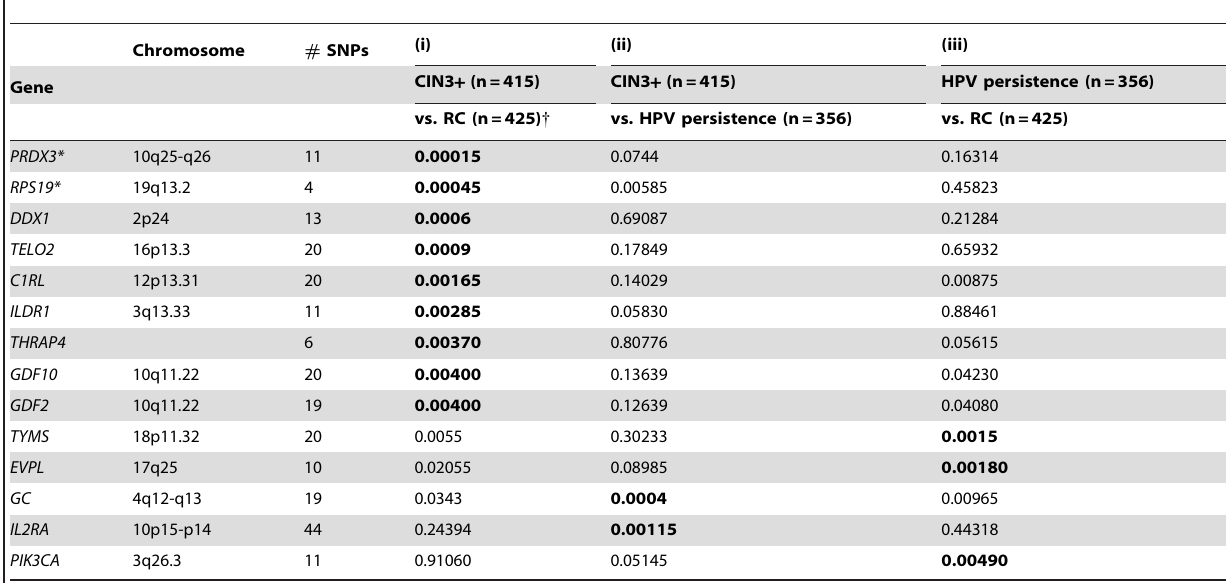
Table 1. Significance levels (p values) for gene regions with p # 0.005, for either an association with (i) cervical precancer/cancer, (ii) progression to cervical precancer/cancer, (iii) HPV